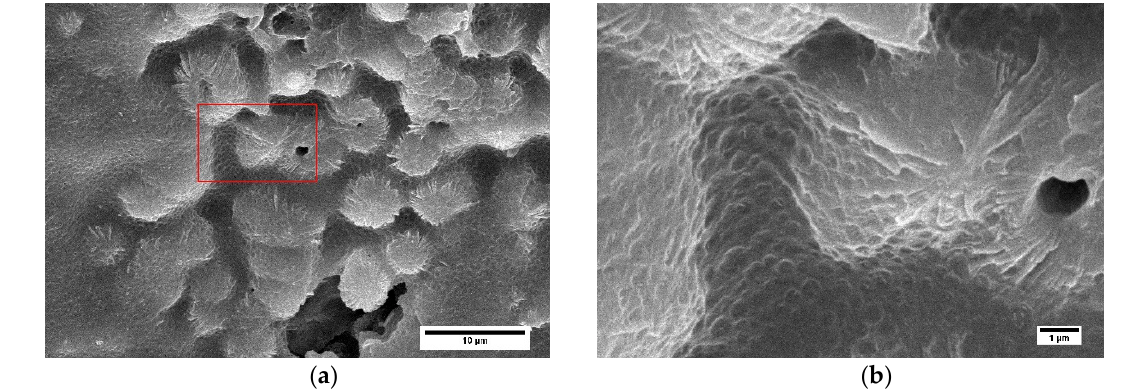
Figure 6. SEM images of a permanganic etched foamed sample (215 L) at 2000 μ m from the skin, in the wall of a cell. The image ( b ) is a zoom of the selected zone of the micrograph to appreciate the elastomeric phase ( a ).